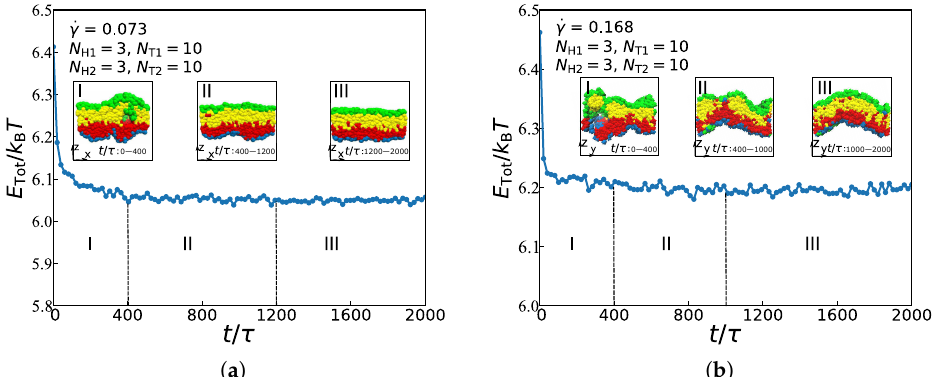
Figure 6. The total energy as functions of time steps for the asymmetric membranes under ( a ) ˙ γ = 0.073 and ( b ) ˙ γ =